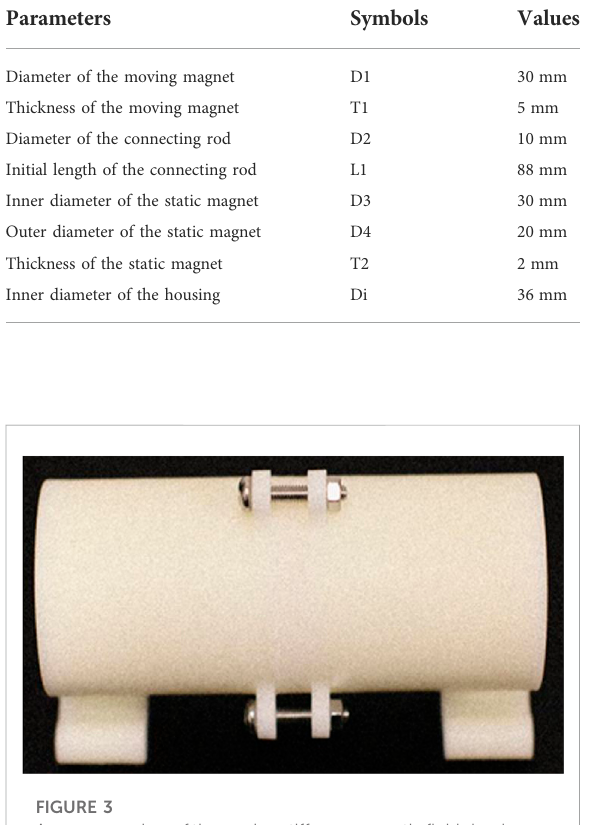
FIGURE 4 Photograph of experimental apparatus of vibration system.